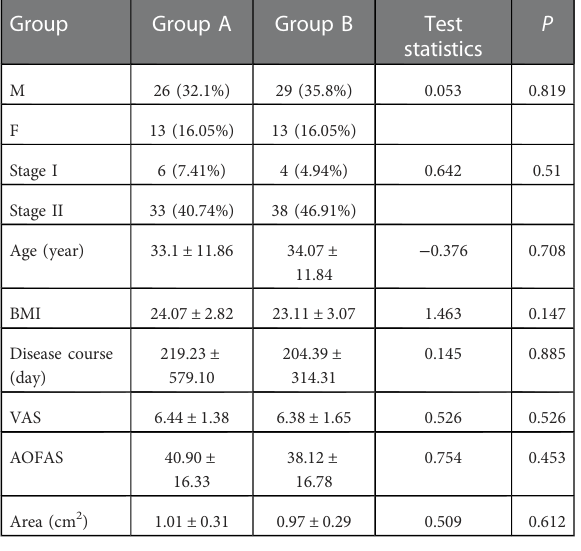
TABLE 1 Comparison of preoperative characteristics between the two